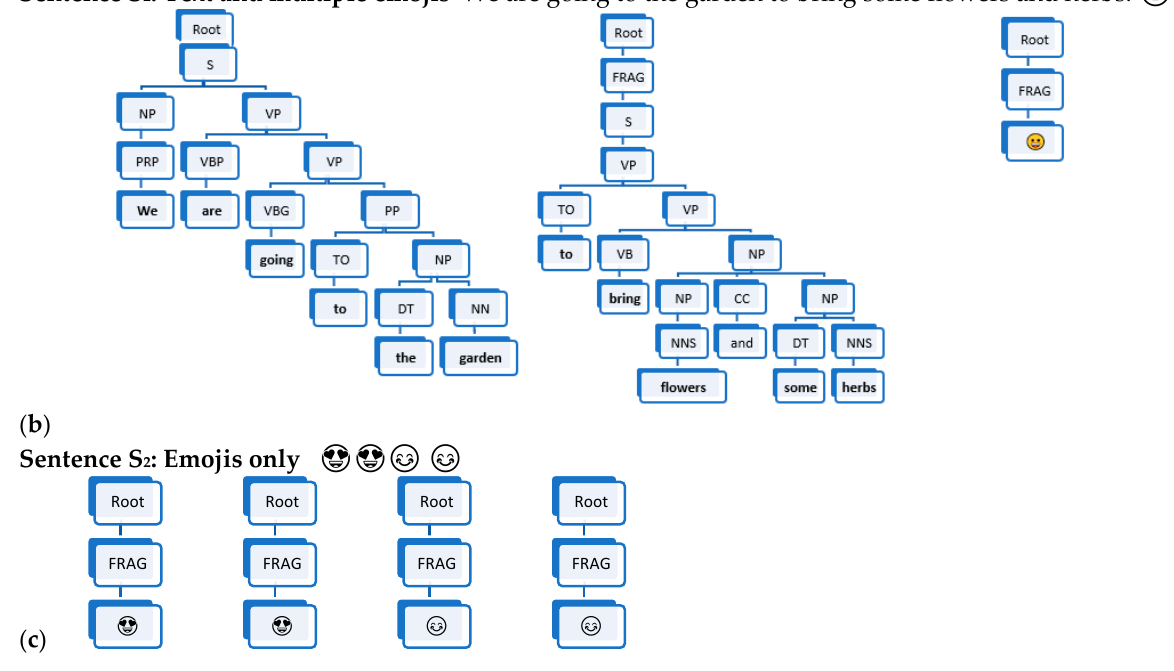
Figure 2. Tree formation for sentiments with ( a ) text and emoji both ( b ) text and multiple emojis ( c ) emojis only. Table 2. POS combinations for n-gram based on text and emoji and multiple-emoji combinations.